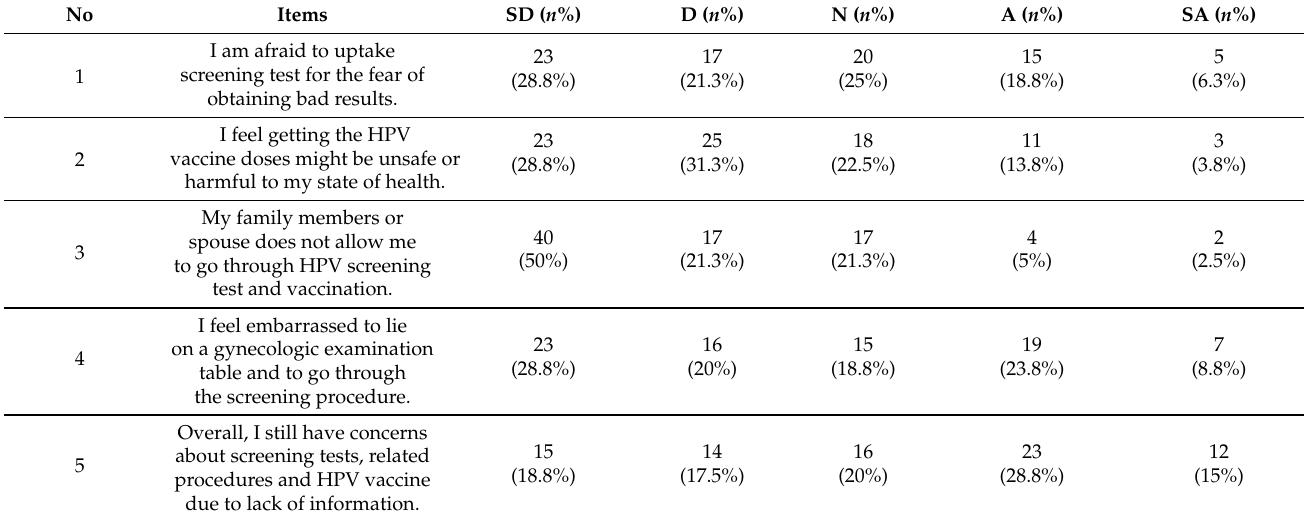
Table 2. Descriptive Statistics of Perceived